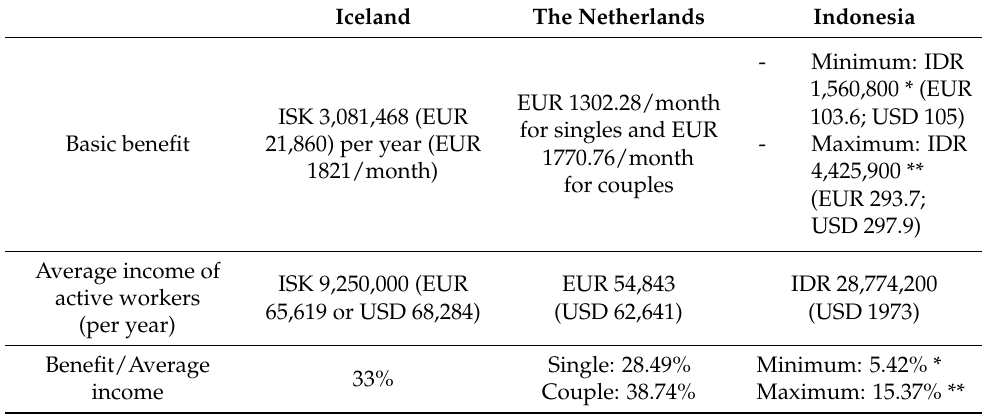
Table 4. Comparison of pension benefits of public pension in Iceland, the Netherlands, and